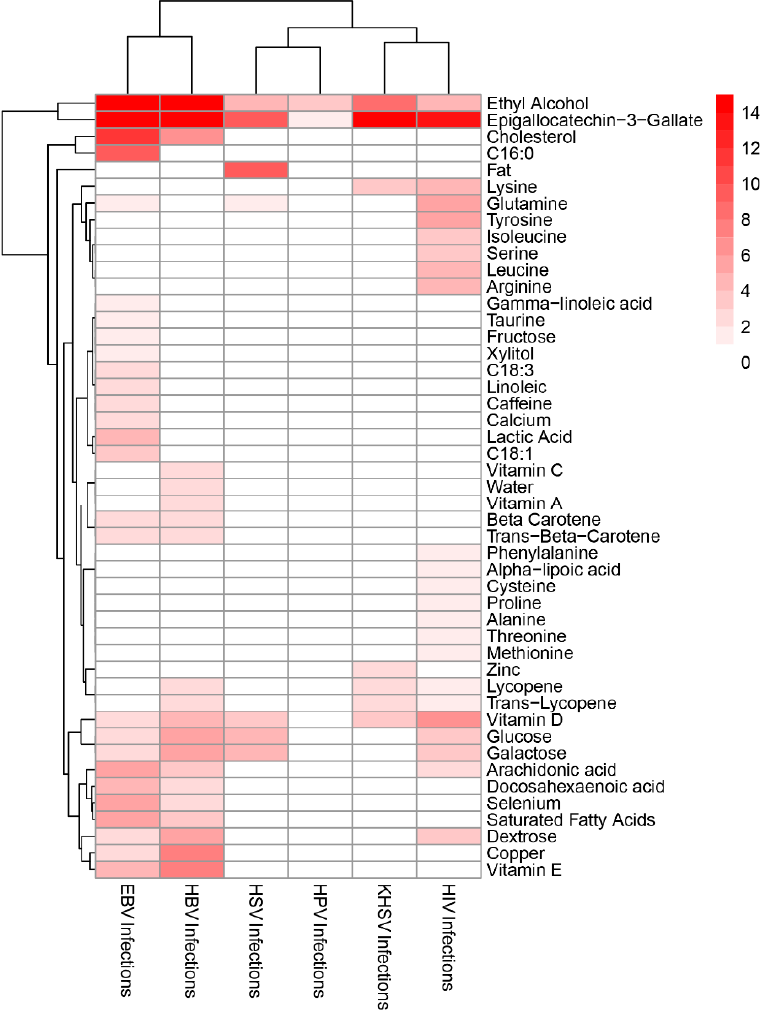
Figure 7. The analysis results of interaction between viral infection and nutrients. There are 47 interactions between nutrients and viral infections. The darker the color, the higher the confidence of the interactions (based on adjusted p ‐ values of hypergeometric distribution tests). The scale in the figure indicates the decimal units of p , with the norm of adjusted p ‐ value ranging from less than 1 × 10 − 14 to 1.